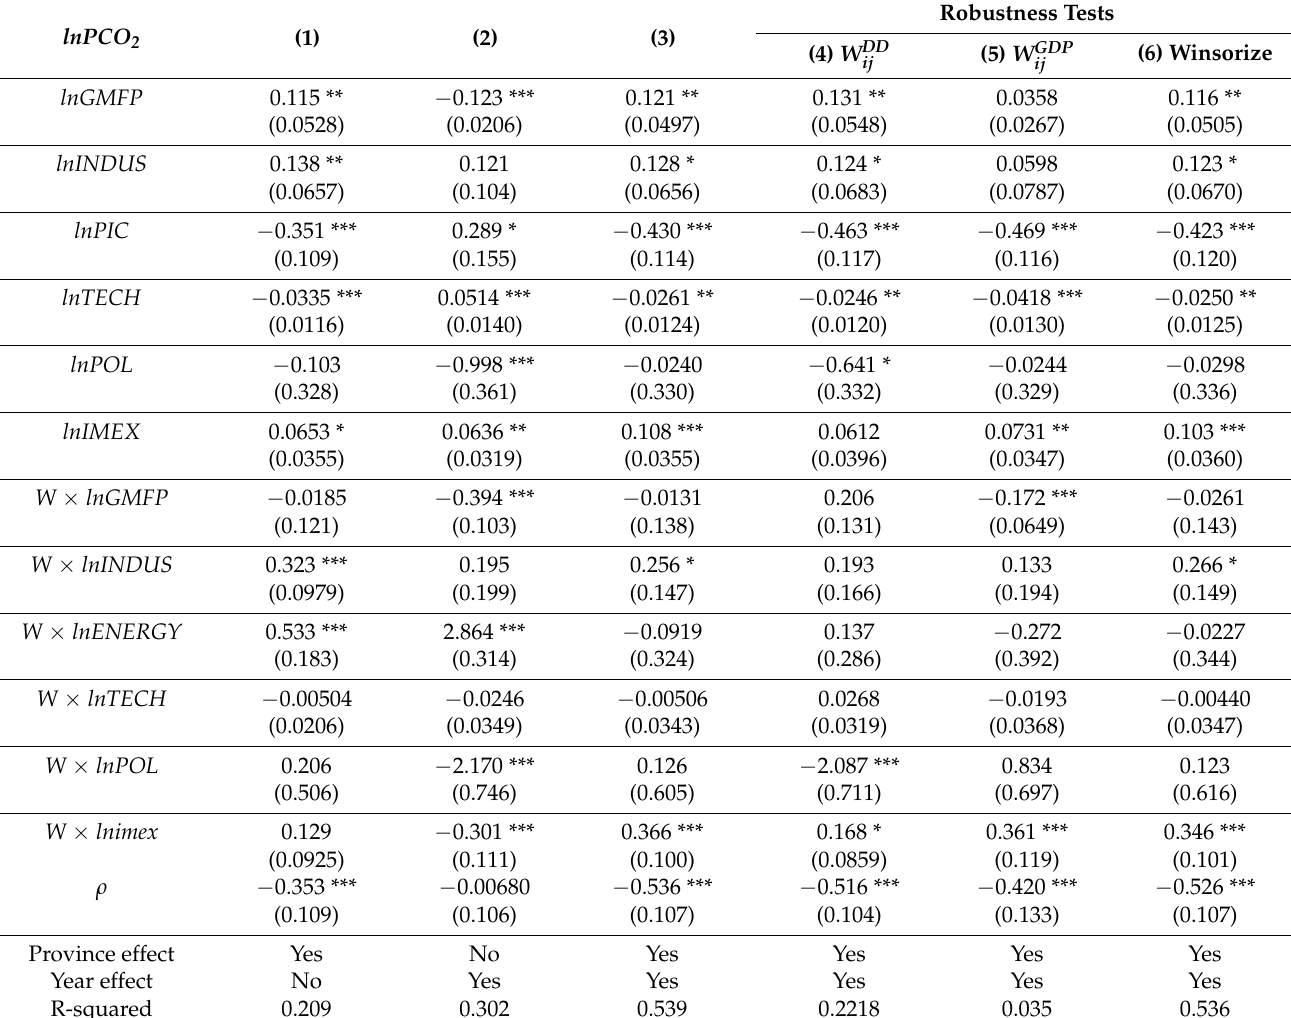
Table 4. Estimated results and robustness